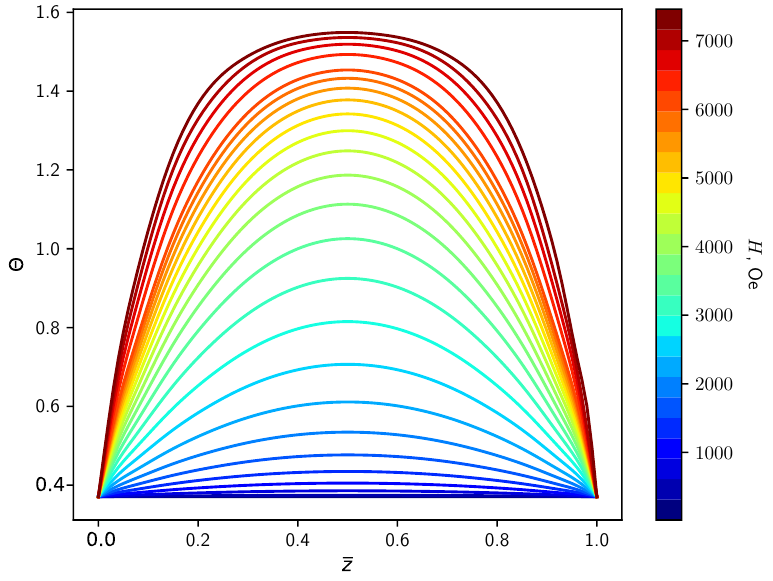
Figure 5. Profiles of the angle θ on ¯ z for the Gd complex with various H